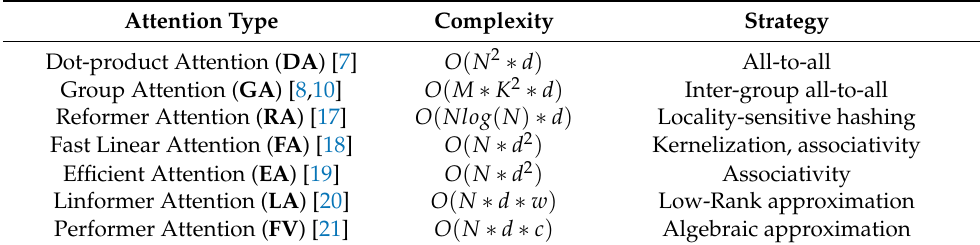
Table 1. An overview of some sub-quadratic attention strategies. Attention Type